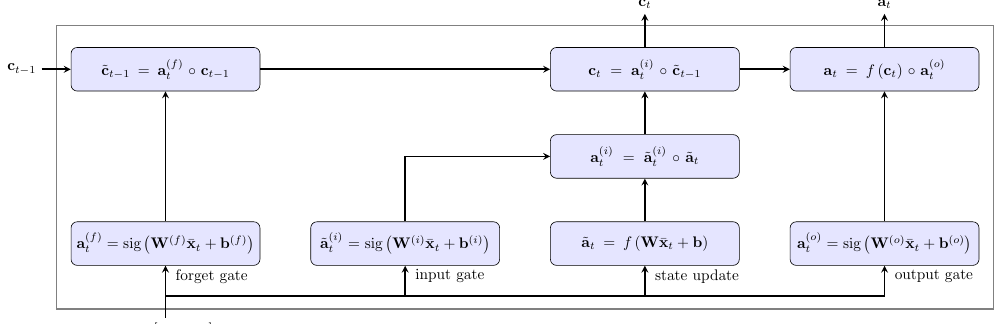
Figure 4. Overview of an LSTM cell. In each cell, four different networks are trained (bottom line) to be able to memorise relevant information over long time. According to the information, the internal cell state c t and the activation a t are updated and used as further inputs during the next